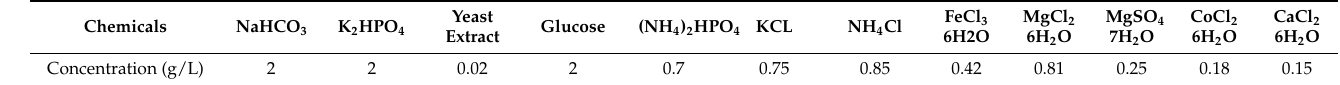
Table 1. Substrate compositions used in the artificial effluent (per 1 L)